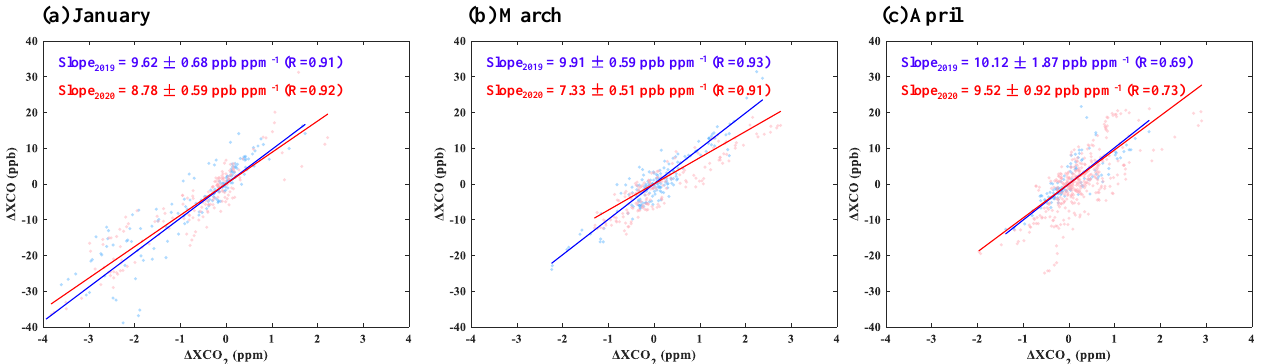
Figure 5. Correlations of ∆ XCO and ∆ XCO 2 in ( a ) January, ( b ) March and ( c ) April of 2019 (blue) and 2020 (red); slope2019